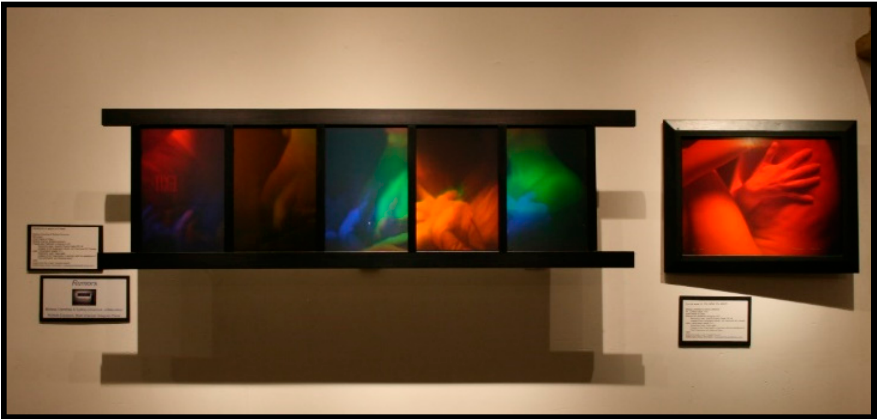
Figure 11. These pseudo-color reflection holograms were created in collaboration with Sydney Dinsmore. Rumours 1992 multi-channel panel (14 ″ × 48 ″ ) is on the left and the figure from the series Is This What You Want , 1988, 12 ″ × 16 ″ ) is on the right.